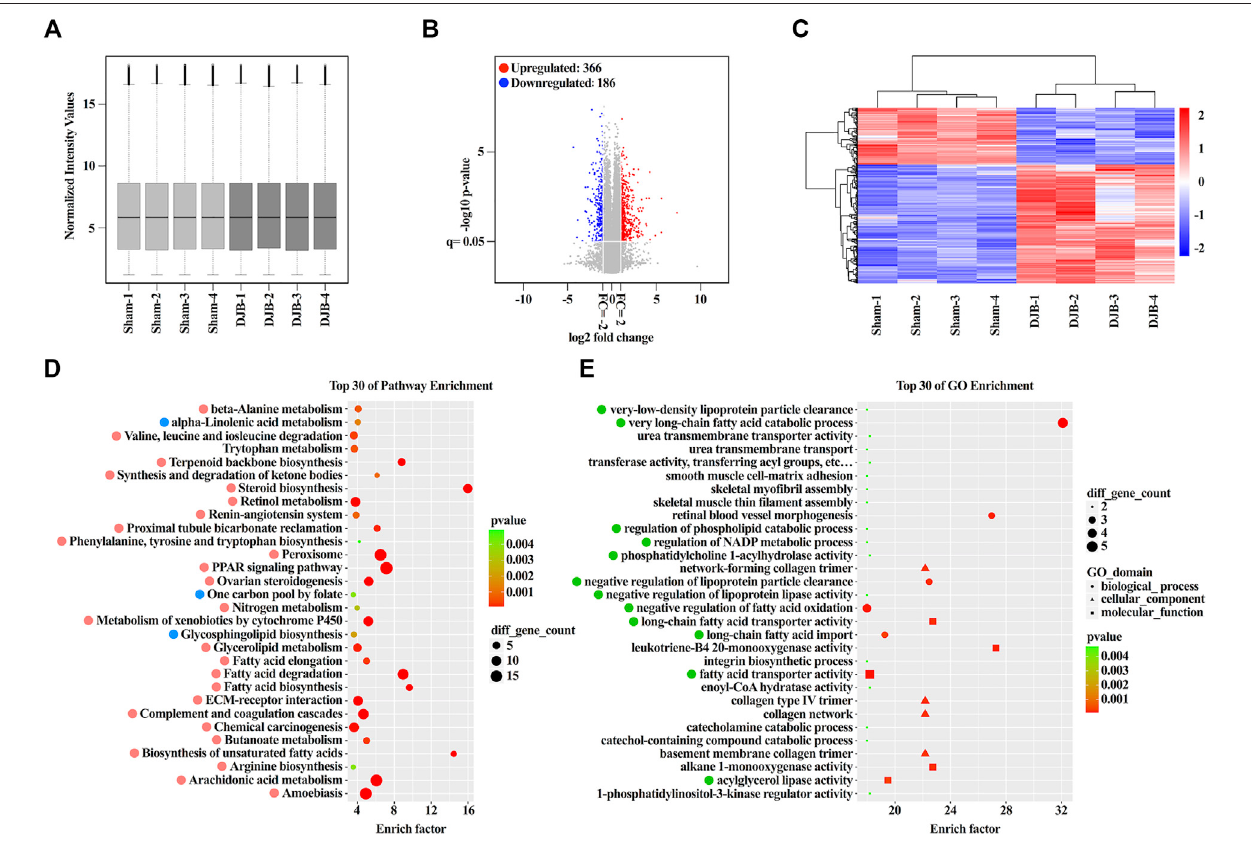
FIGURE2| OverviewandbioinformaticanalysisoflncRNA-co-expressedmRNApro fi les. (A) Box-plotshowingthenormalizationofallsamples. (B) Volcanoplotof differentially expressed mRNAs between DJB and sham groups. (C) Heat map of mRNAs showed hierarchical clustering of differentially expressed mRNAs in DJB and sham mice (fold change ≥ 2, p < 0.05). Red and blue, respectively, representhigh and lowrelative expression. (D) Top 30signi fi cantlyenriched pathways ranked with an enrichmentscore( p < 0.05).Up-anddownregulatedpathways aremarkedwithsoftred andsoftblue, respectively. (E) Top30signi fi cantlyenriched GOitems ( p < 0.05). The important items are marked with